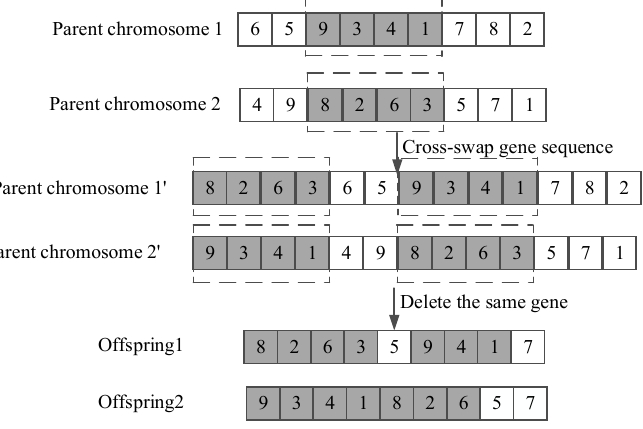
Figure 6. Schematic diagram of the improved two-point crossover operation process.